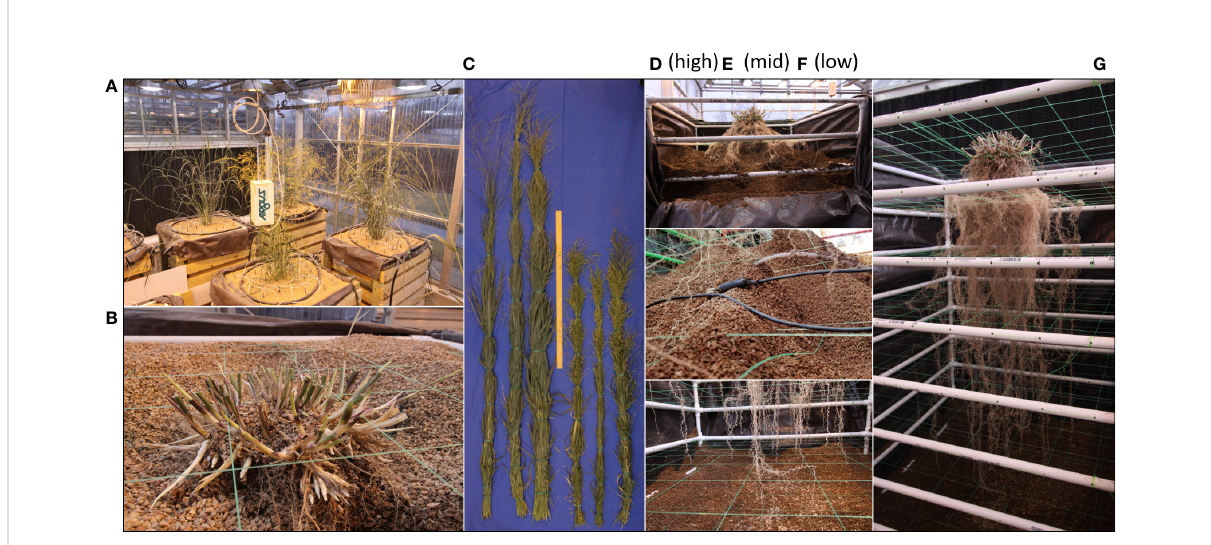
FIGURE 3 Mesocosm harvest method. Mesocosms supporting the growth of full size WBC3 and VS16 switchgrass genotypes (A) . At harvest the shoots are cut a few centimeters above the soil pro fi le (B) . Shoots are bundled and dried for biomass measurements to accompany other shoot morphological traits collected during growth ( C ; Figure S2). Harvest begins by removing the uppermost exterior 2x6s, removing the masonite and pulling back the tarp to expose the top of the growth pro fi le for excavation (D) . Throughout sensors will be carefully extracted from the root system so as not to disturb the architecture (E) . Harvest continues until all root tips are exposed from the growth media (F) . Following complete excavation, the root system can be relocated in the PVC and fi shing line scaffold and stored for future analysis (G)